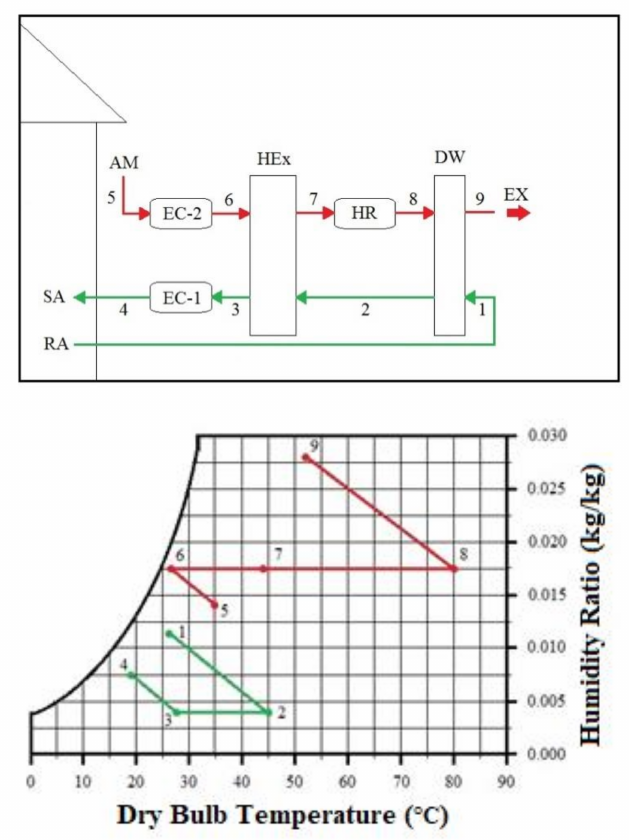
Figure 4. Recirculation